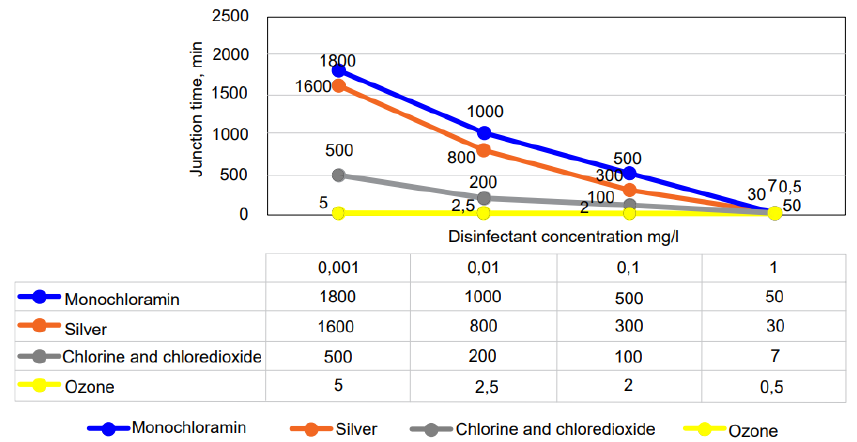
Figure 3. The effect of various disinfectant methods on E. coli bacteria (where T = 280c and pH = 7,5).